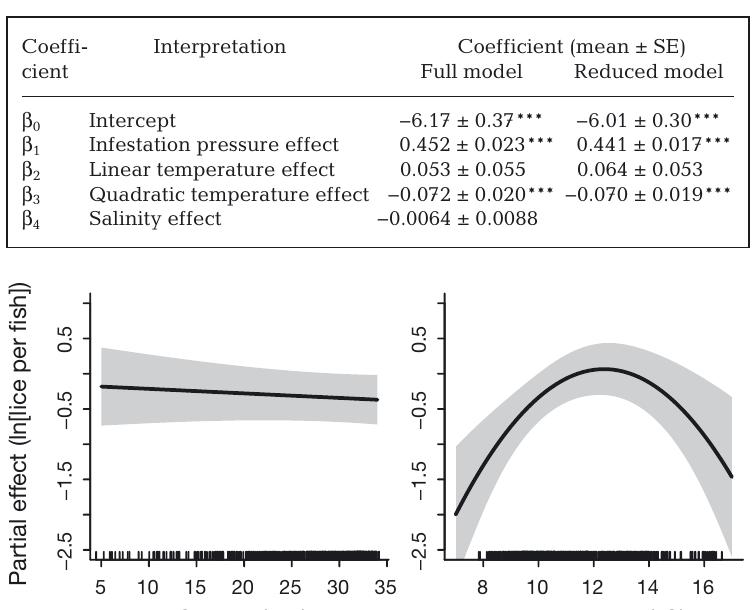
Table 2. Parameter estimates for additive effects of temperature and salinity on salmon lice (Eqs. 9c & 15a). Random-effect standard deviations were σ 1 = 0.98 and σ 2 = 0.76, and the dispersion parameter was θ = 15.3 in both the full model and the reduced model with the non-significant salinity term removed.